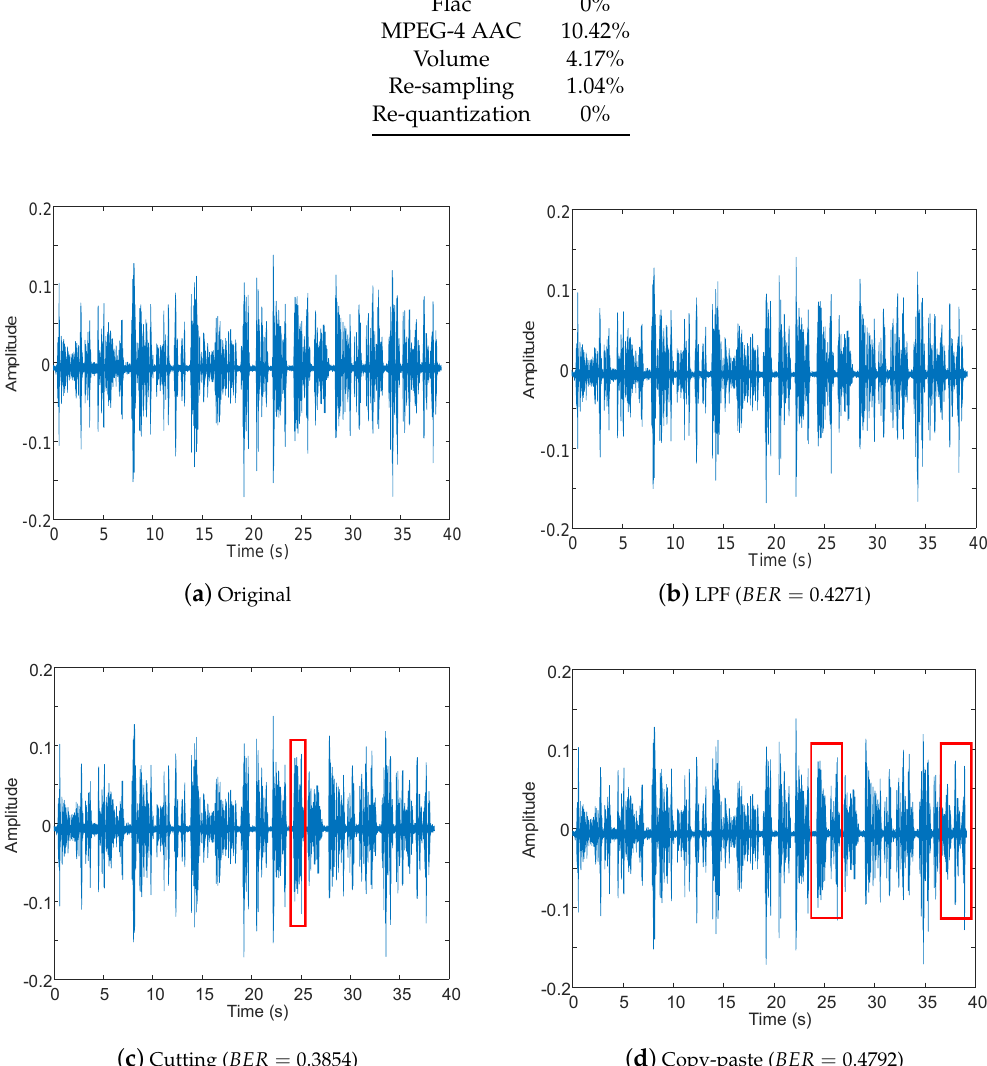
Figure 4. Examples of non-perceptual manipulations and BER value between the hash of the original signal and the hash of the modified